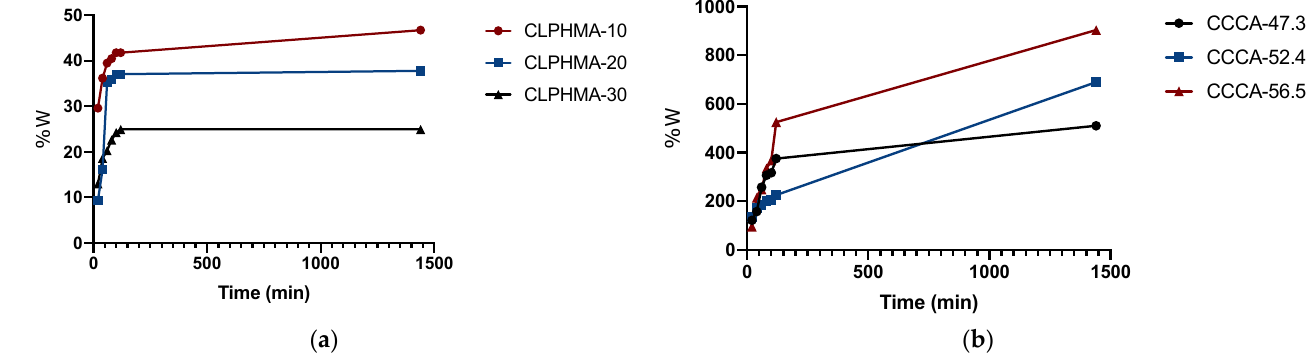
Figure 6. Swelling index of ( a ) CLPHMA and ( b ) CCCA in distilled water (pH 5.5) with respect to time.